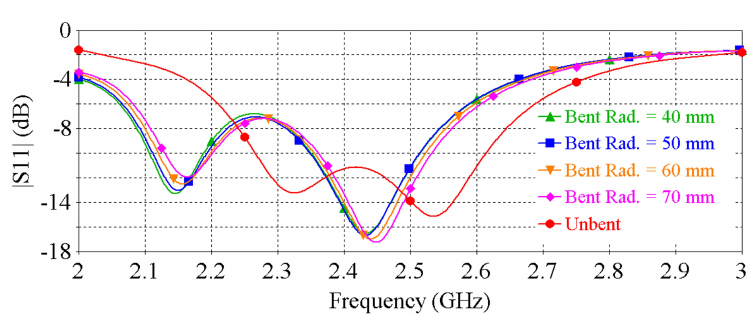
Figure 8. | S 11 | vs. frequency of the antenna for different bending radius.